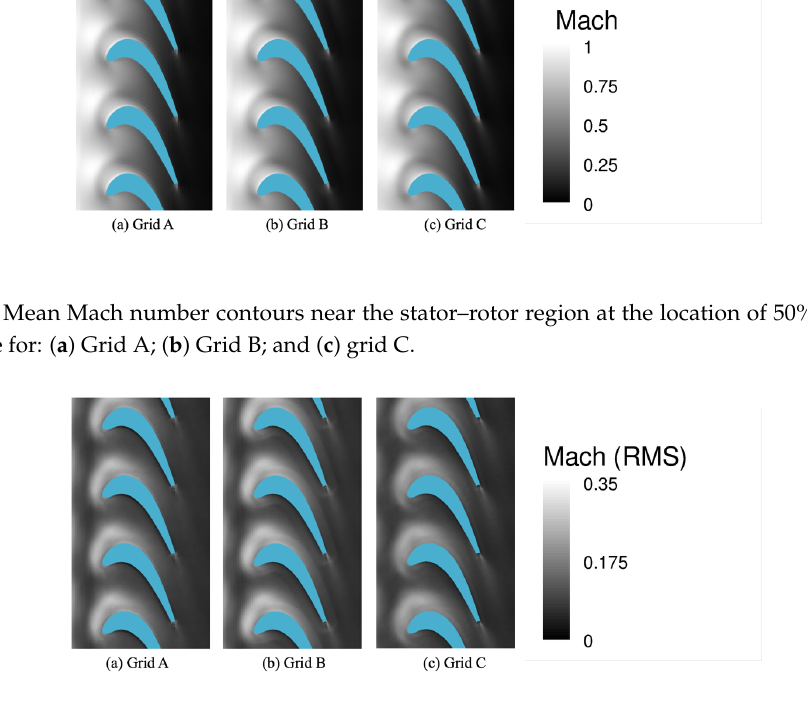
Figure 13. Contours of RMS value of Mach number near the stator–rotor region at the location of 50% span of the rotor blade for: ( a ) Grid A; ( b ) Grid B; and ( c ) grid